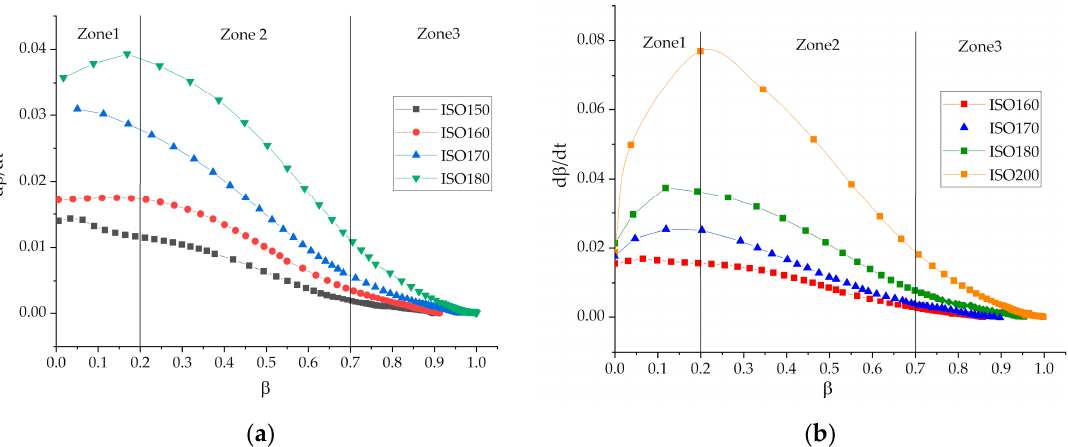
Figure 5. The curing rate-dependencies (d β /dt) on the degree of conversion ( β ) for formulations 1 ( a ) and 2 ( b ).